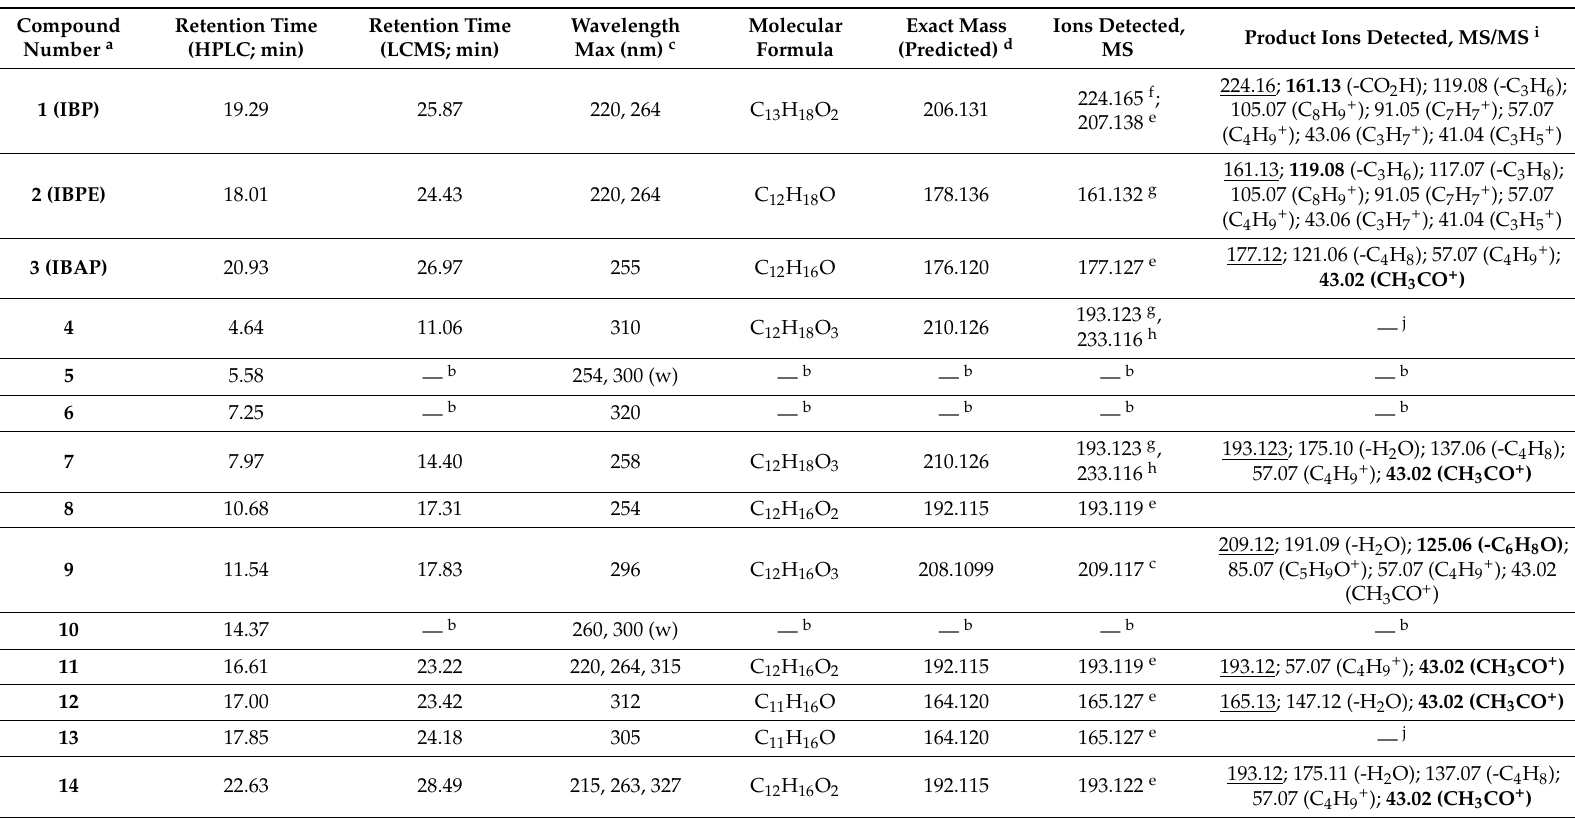
Table 3. Compounds identified by HPLC-DAD and LC-MS/MS. Reused with permission from reference [118]. Copyright Elsevier